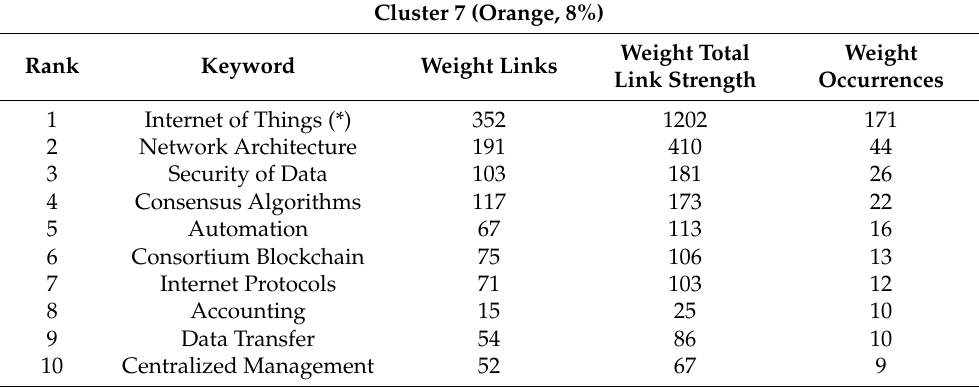
Table 10. Cluster 7